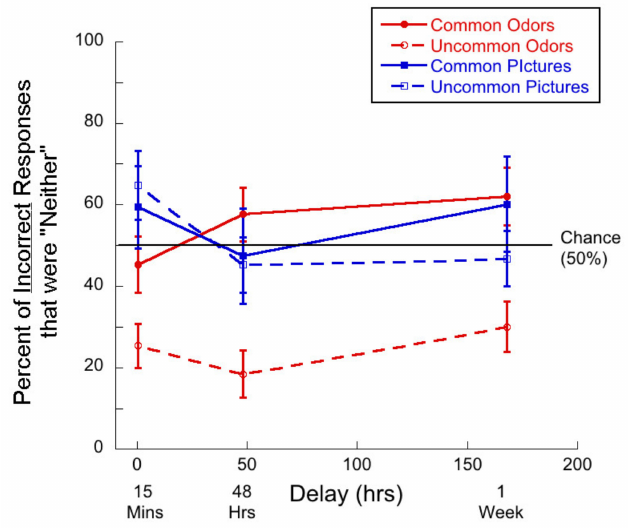
Figure 9. Percentage of “neither” responses as a function of delay for each of the four test conditions. Note that “neither” was never a correct